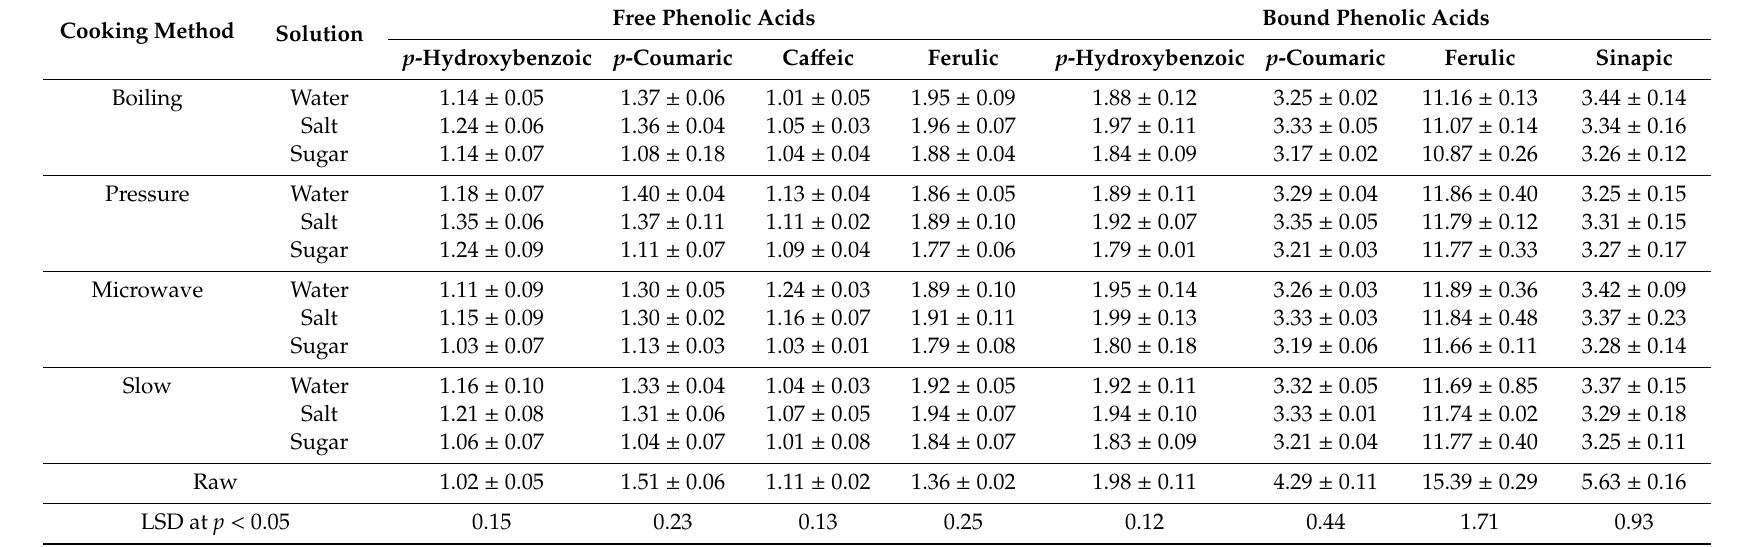
Table 3. E ff ect of four cooking methods on the composition of phenolic acids in peas ( µ g / g,